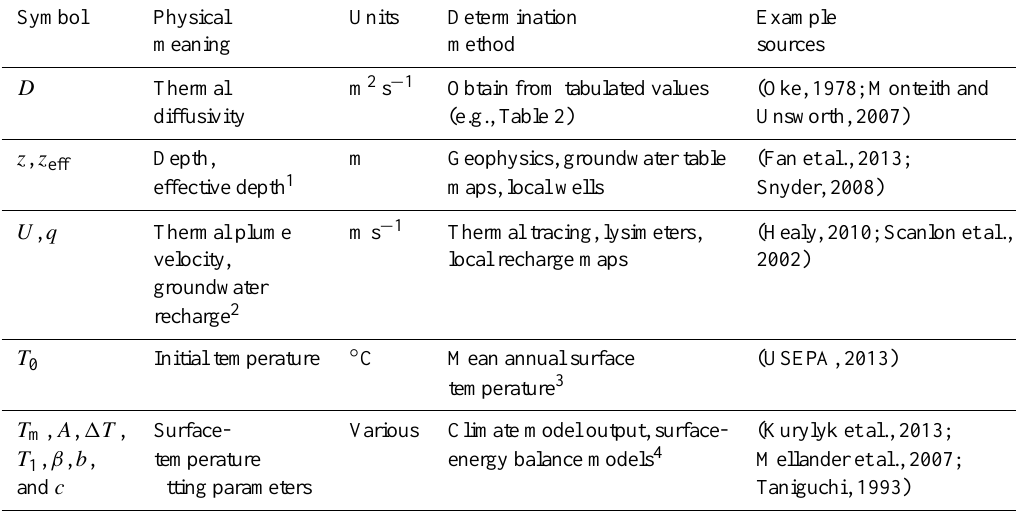
Table 3. Parameters for equations considered in this study. Symbol Units Determination Example Obtain from tabulated values (Oke, 1978; Monteith and (e.g., Table 2) Geophysics, groundwater